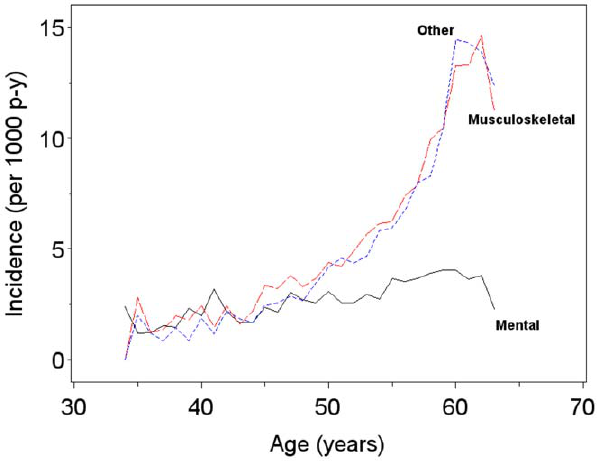
Figure 2. Incidence rates of disability pension per 1000 person- years in each diagnostic group.